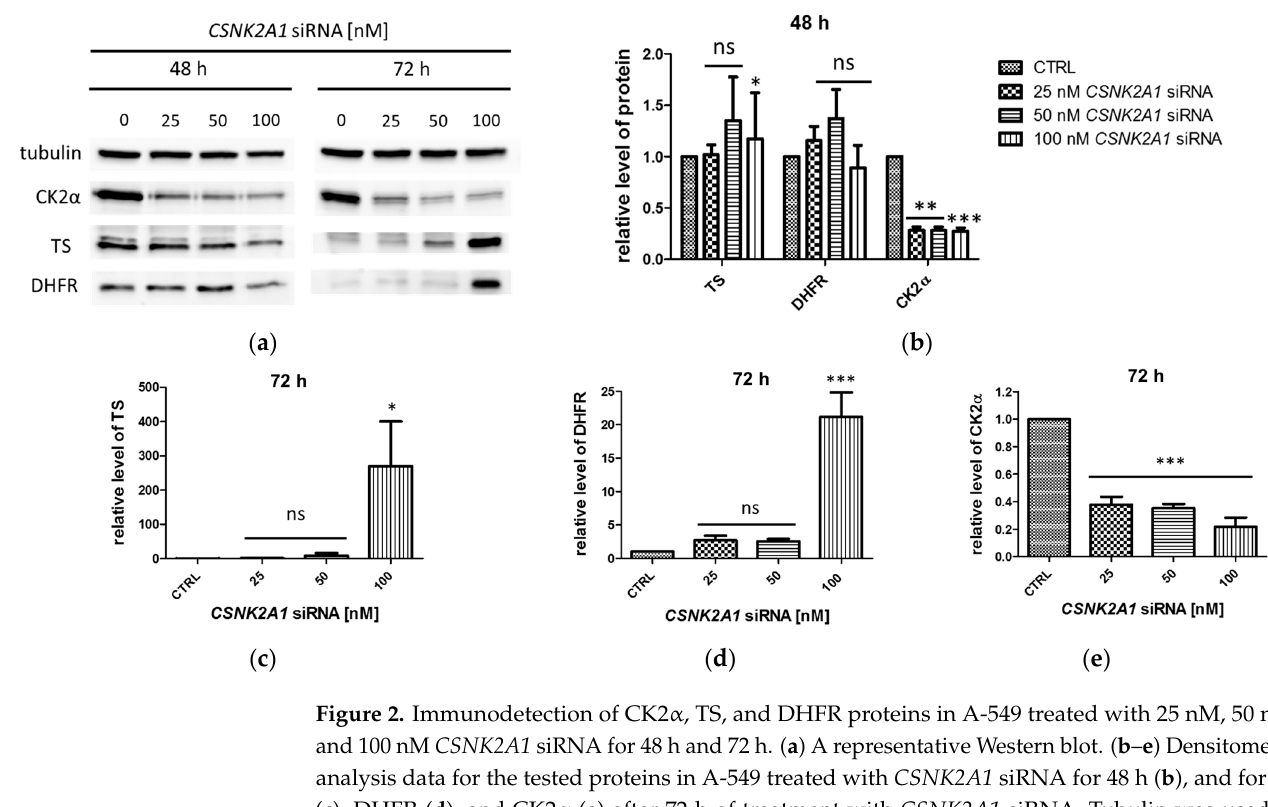
Figure 2. Immunodetection of CK2 α , TS, and DHFR proteins in A-549 treated with 25 nM, 50 nM, and 100 nM CSNK2A1 siRNA for 48 h and 72 h. ( a ) A representative Western blot. ( b – e ) Densitometry analysis data for the tested proteins in A-549 treated with CSNK2A1 siRNA for 48 h ( b ), and for TS ( c ), DHFR ( d ), and CK2 α ( e ) after 72 h of treatment with CSNK2A1 siRNA. Tubulin was used as a loading control for each sample. Section 4 describes the preparation of cell extracts and protein detection. Densitometry quantifications for each tested protein, given under each cell line panel, were calculated with untreated cells (CTRL) as the reference point. Graphs represent mean values ± s.e.m. * p < 0.05, ** p < 0.01, *** p < 0.001, relative to control; ns—not significant.